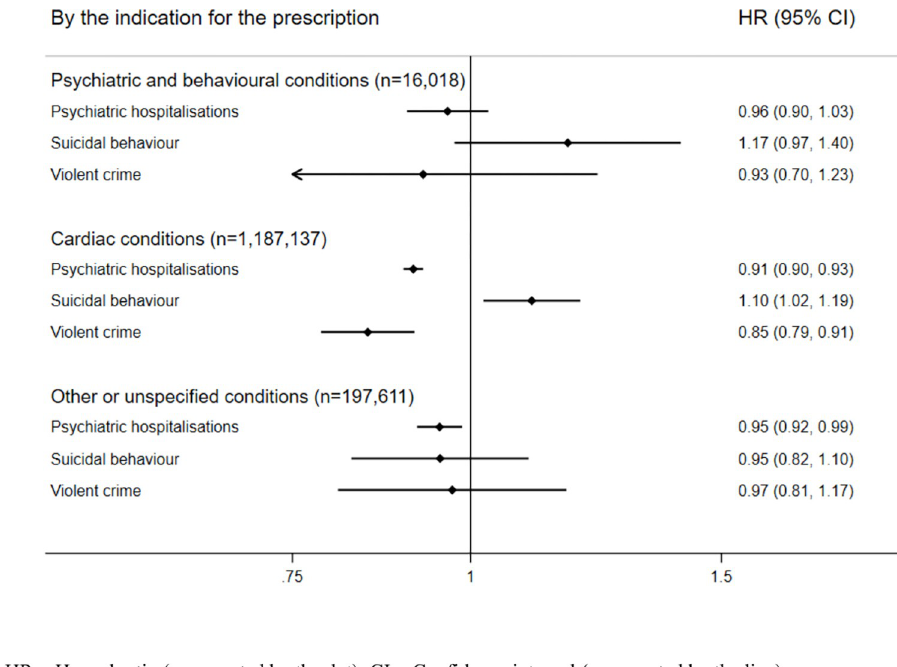
Fig 2. Age-adjusted within-individual associations between β -blockers and psychiatric and behavioural outcomes stratified by the indication for prescription. CI, confidence interval; HR, hazard ratio.